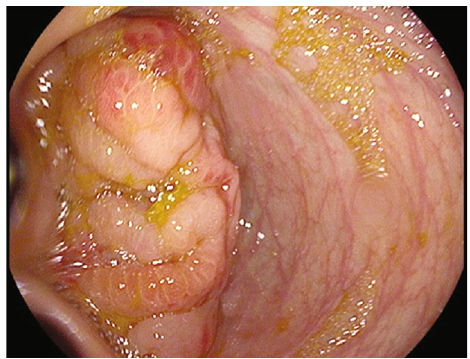
Figure 2: Caecal mass as seen on colonoscopy.